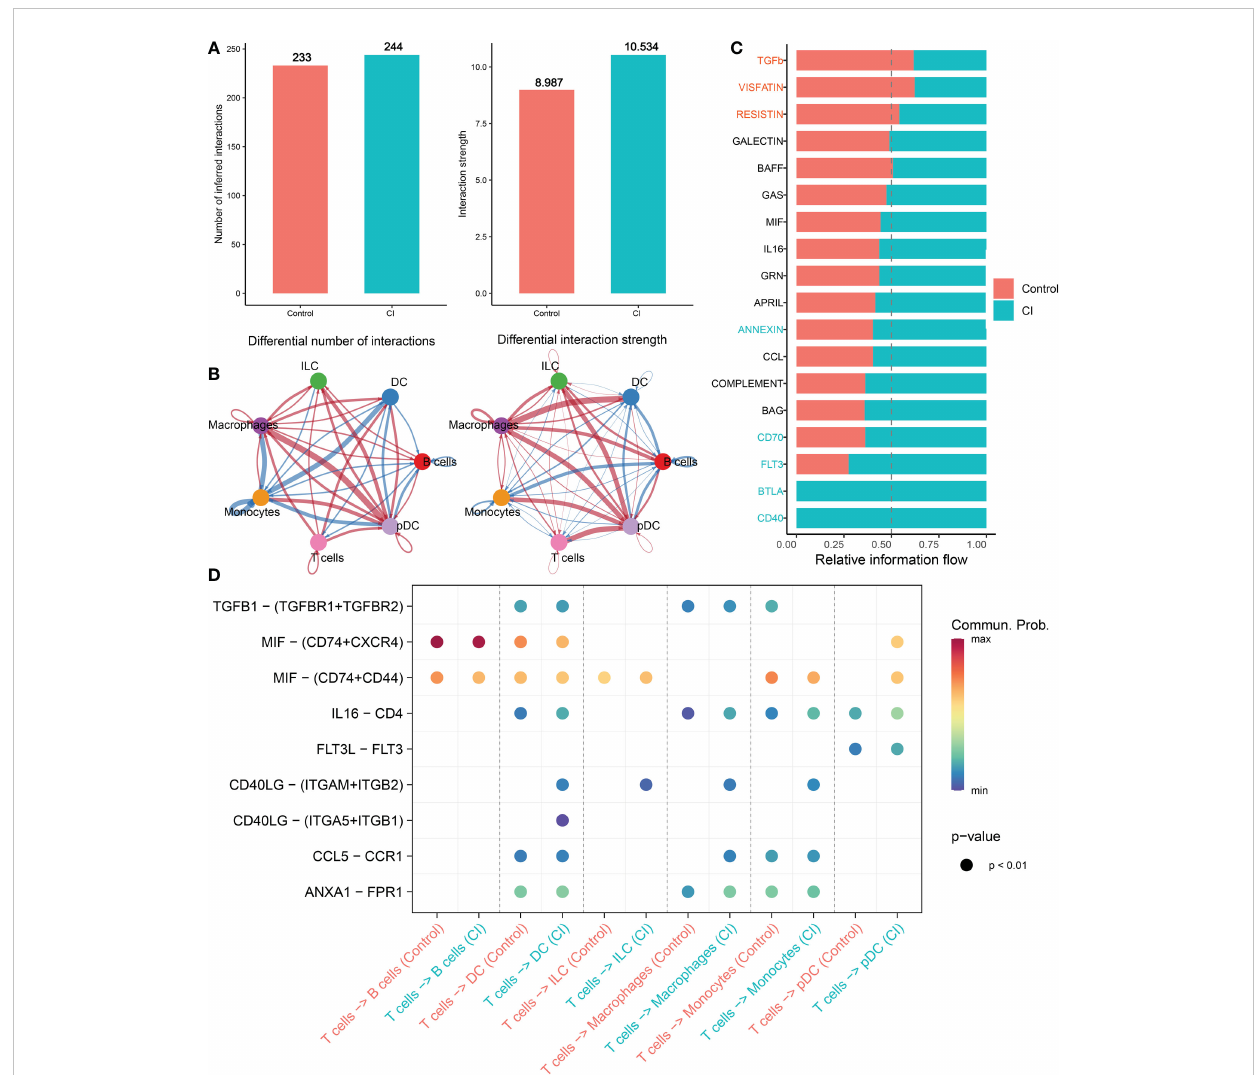
FIGURE 4 Intercellular communication difference between Normal and AD single cells . (A, B) Bar and circle charts showing the differences in the number of interactions (left) or strength of interactions (right) in the network of cell-cell communication between normal and CI groups. Thicker lines representing stronger interactions, and red or blue colors representing greater or decreased signaling in AD patients when compared with normal group, respectively. (C) Stacked plots exhibiting the differences in intercellular signaling pathways between CI and normal groups. Orange and green colors denote up-regulated signaling pathways in normal and CI samples, respectively. (D) Dot plot indicating the difference in signaling molecules from T cells to other immune cells between normal and cognitively impaired CSF